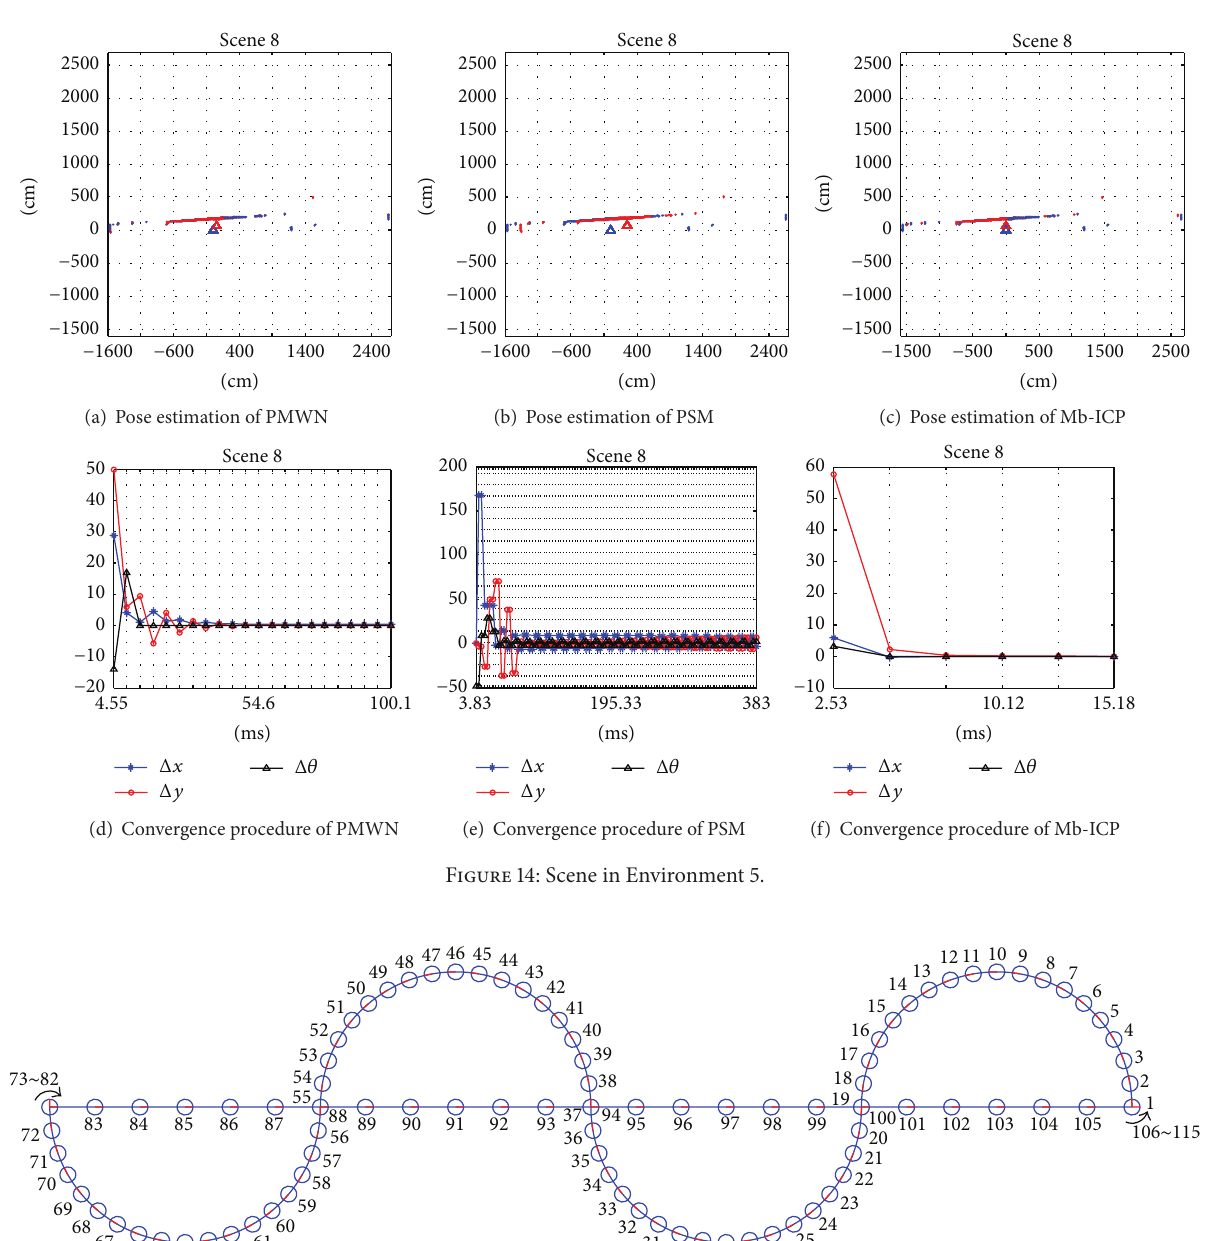
Figure 14: Scene in Environment 5.